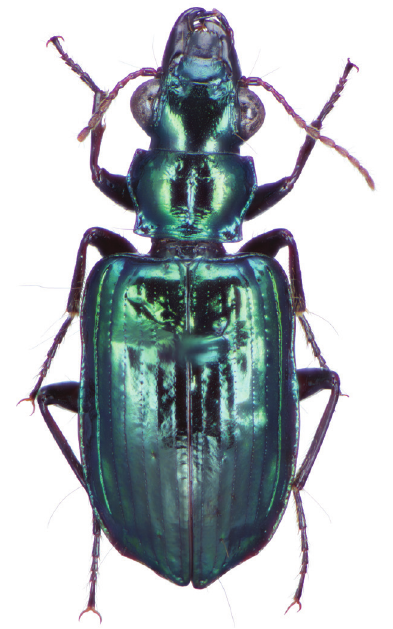
Figure 21. Dorsal habitus and color pattern of Catascopus ( s. str. ) asaharti sp. n. (OBL 8.75 mm). Fixed setae. Pronotum with two pairs of setae, one at base of lateral margin and one on lateral margin at pronotum max width; elytra with one seta at basal quarter of interval 3, one seta in interval 3 just beyond mid-length, one seta in apical quarter of interval 3; femur of meso-leg with several moderately long seta on dorsal surface and two long setae ventrally in